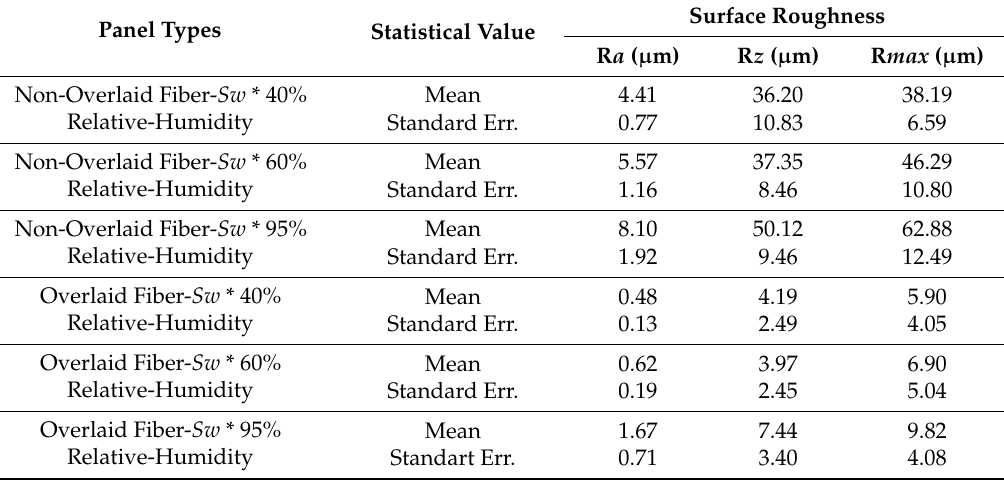
Table 1. Average surface roughness (R a ) values of fiber-sandwich composite panels.